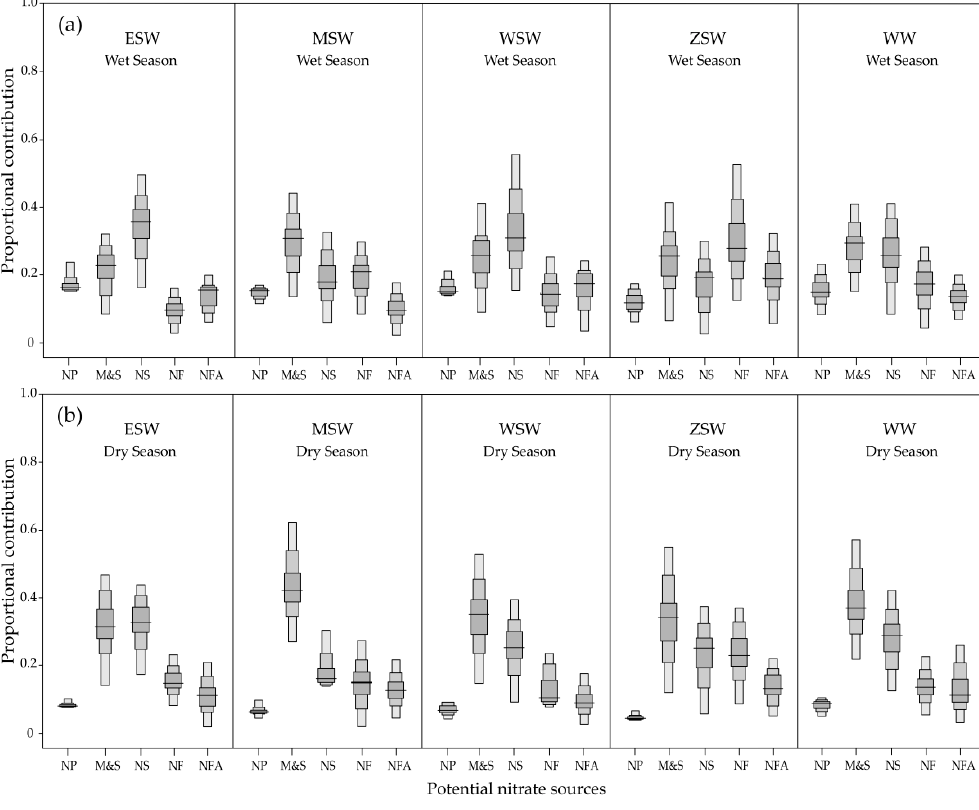
Figure 6. Proportional contributions of five potential nitrate sources in wet season ( a ) and dry season ( b ) estimated by SIAR (Stable Isotope Analysis in R). Boxplot illustrate the 90%, 75%, 50%, and 1% confidence intervals from light to dark.